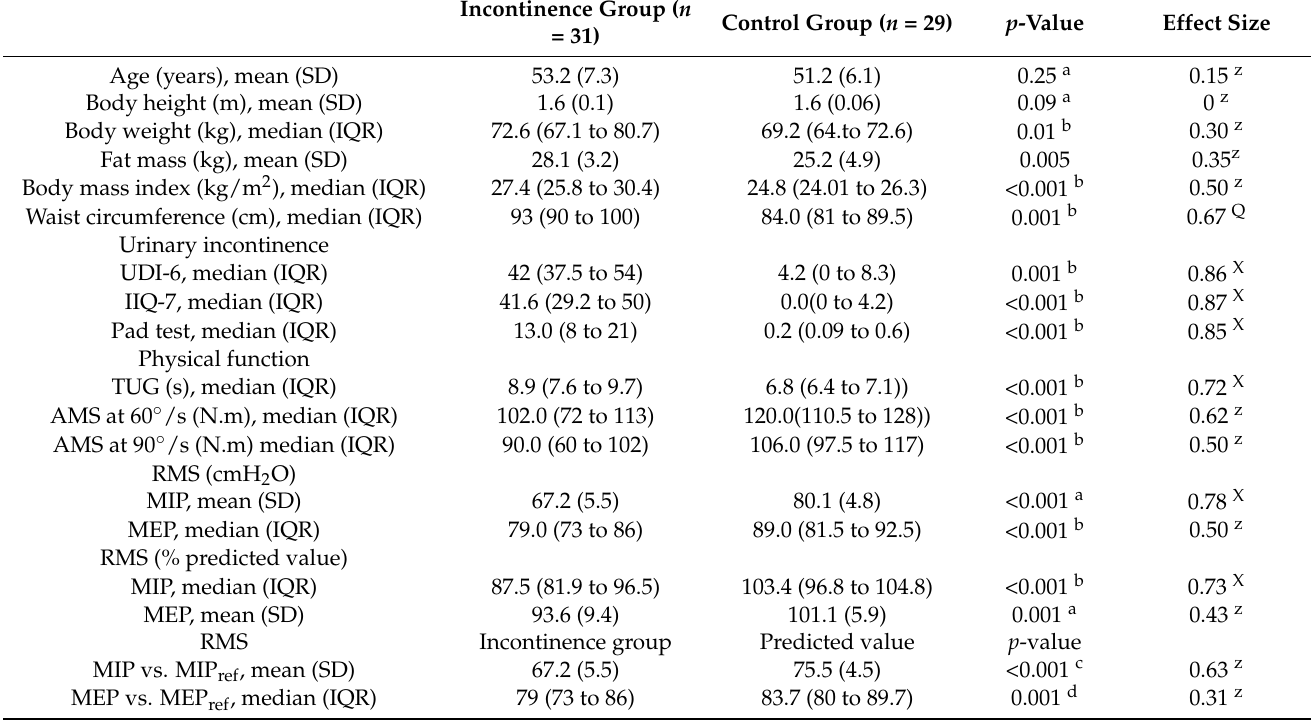
Table 1. Characteristics of the